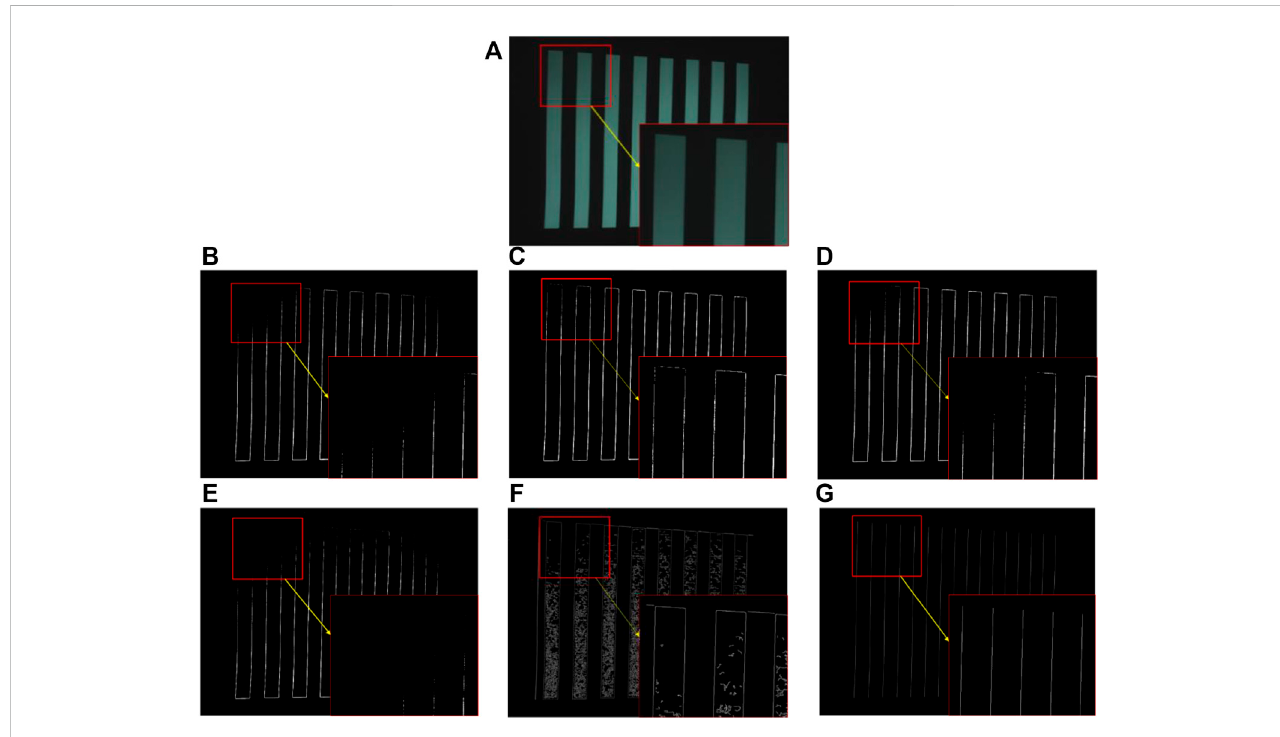
FIGURE 7 Edge detection image. (A) Gray projection plane; (B) Edge image of Sobel operator; (C) Edge image of Robers operator; (D) Edge image of Prewitt operator; (E) Edge image of Laplacian operator; (F) Edge image of Canny operator; and (G) The method we